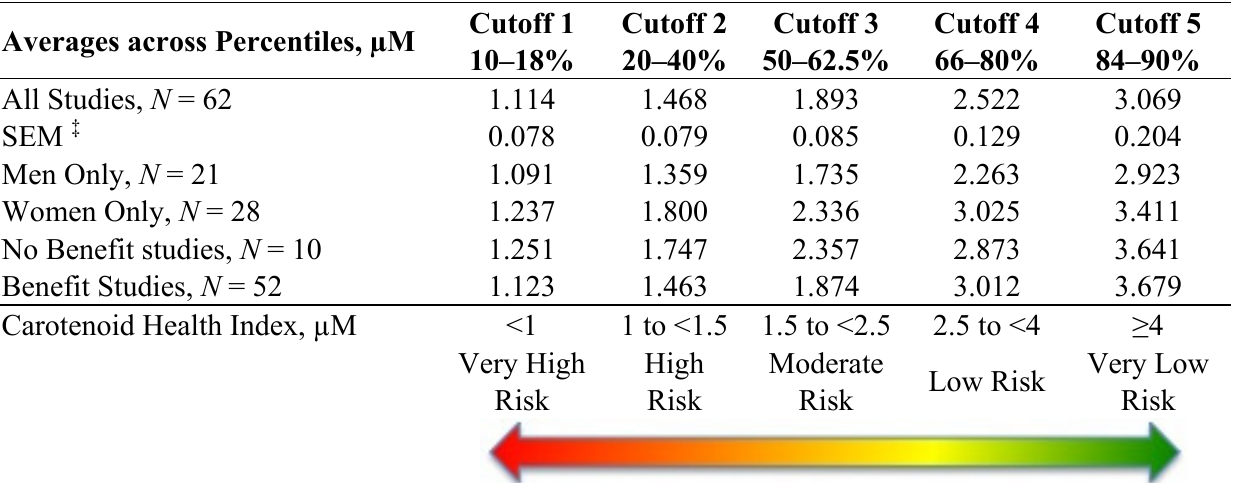
Table 4. Summary of Data for the Carotenoid Health